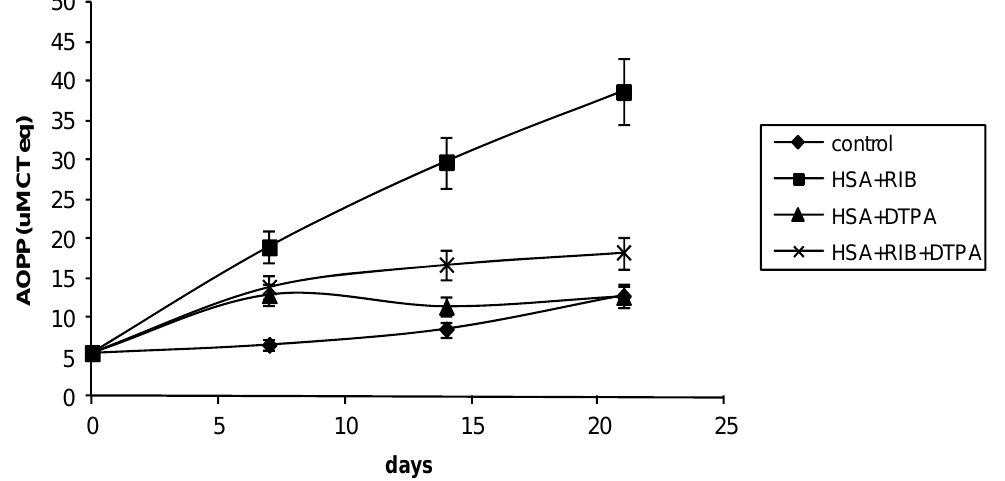
Figure 4. Effects of ribose, DTPA, and ribose + DTPA on AOPP formation in HSA during 21 days of